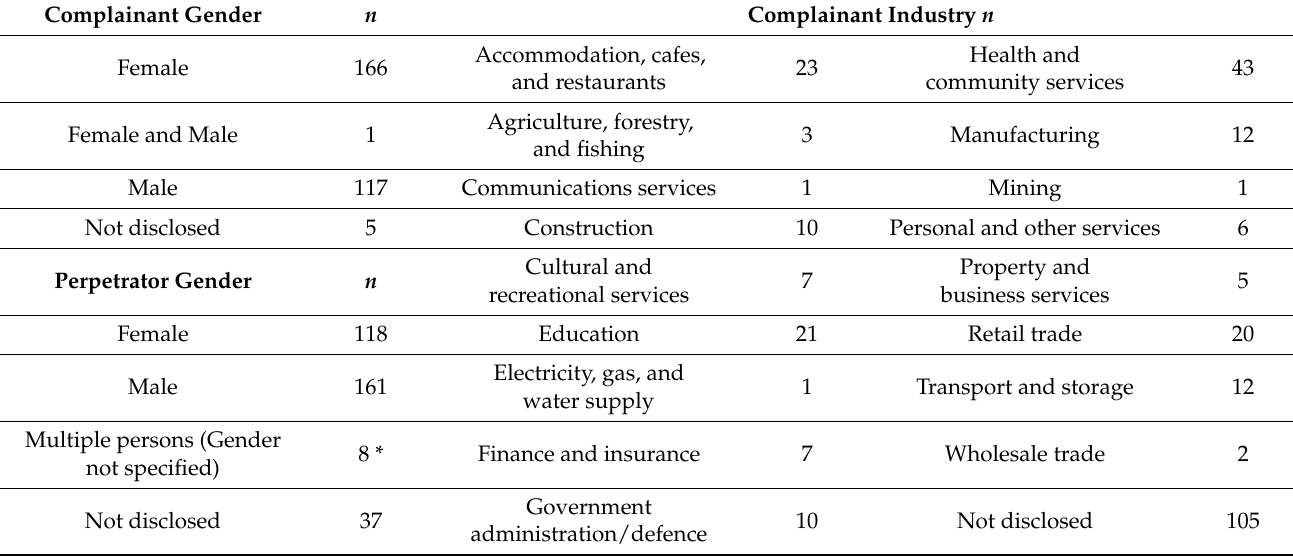
Table 1. Gender of Complainant, Alleged Perpetrator in Relation to the Complaint and Industry that Complaint